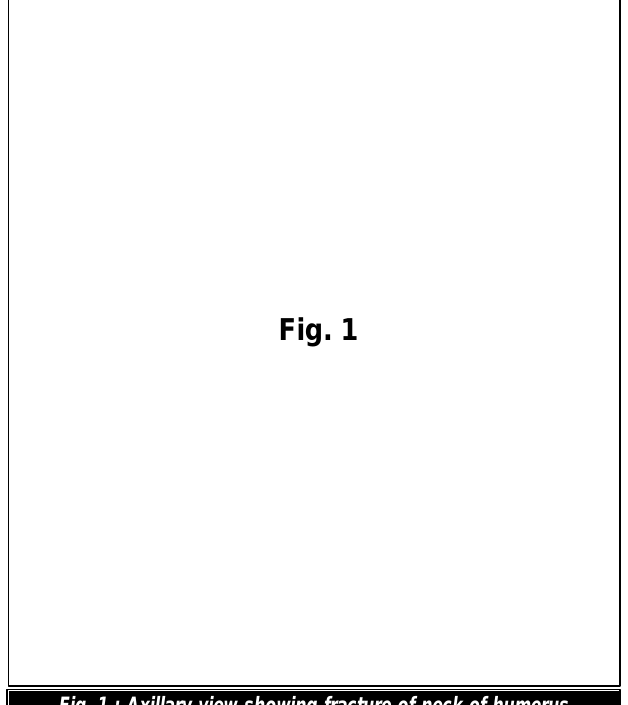
Fig. 1 : Axillary view showing fracture of neck of humerus and of base of coracoid